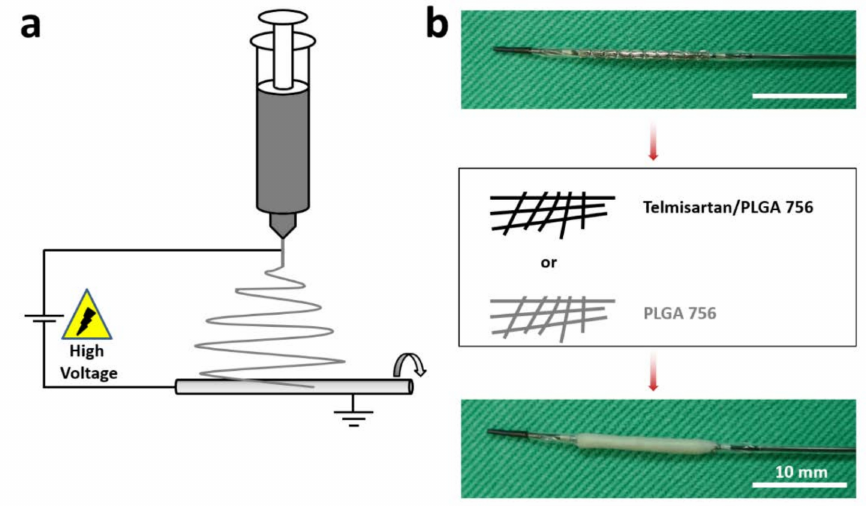
Figure 1. ( a ) Electrospinning schematic. ( b ) Entire coating process. Coating a bare metal stent (3.0 × 14 mm) with either Telmisartan/PLGA 756 or PLGA 756